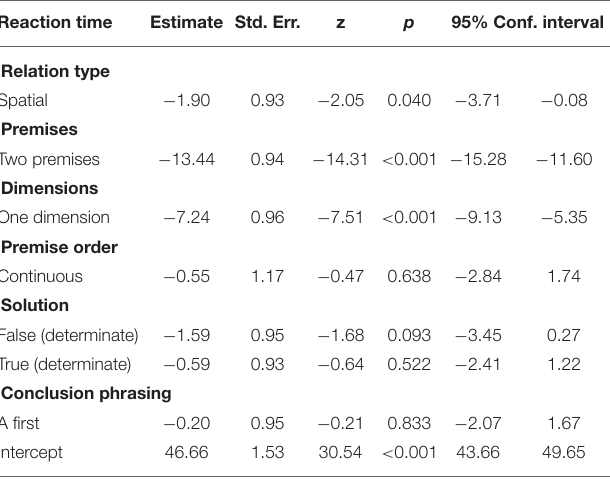
TABLE 2 | Mixed-effects linear regression model for reaction time (fixed effects). Reaction time